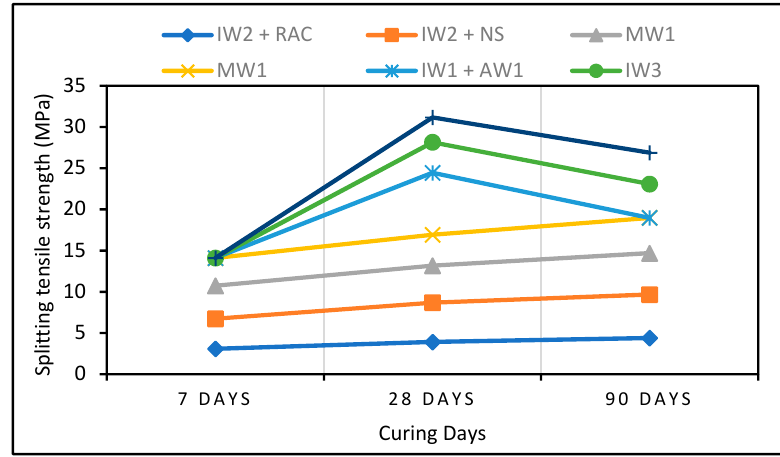
Figure 11. Splitting tensile strength values for polymer concrete mixes for different SCMs.